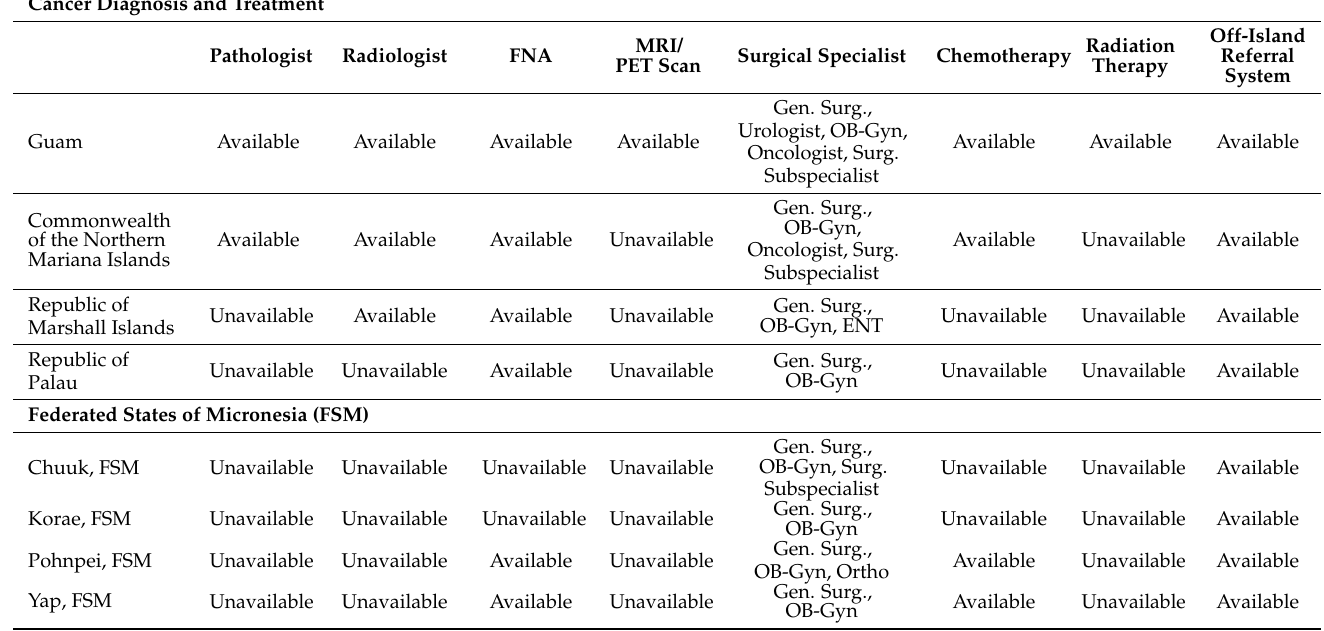
Table 5. Summary table of available cancer diagnostic and treatment services in the USAPI. Data based on Pacific Regional Central Cancer Registry 2007–2018 report